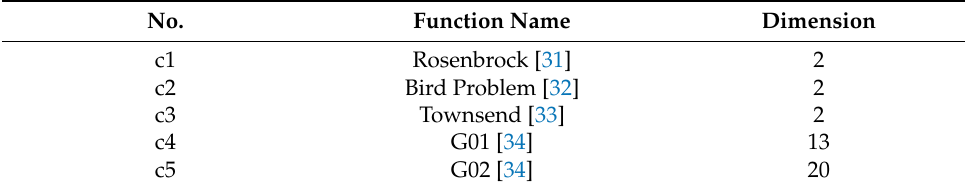
Table 3. Benchmark functions (Constrained).